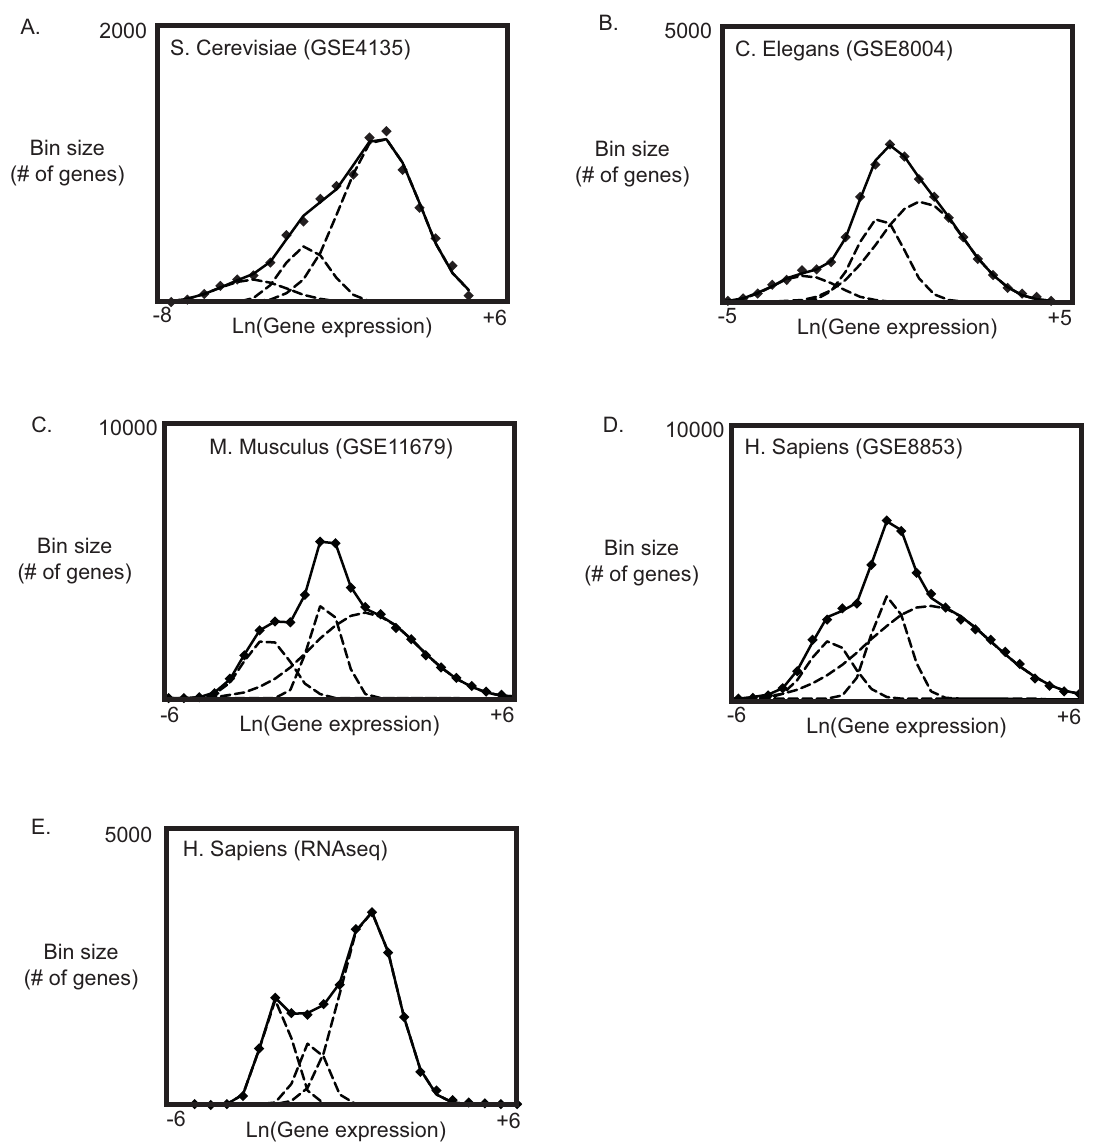
Figure 6. The presence of 3 log-normal gene expression distributions is a universal feature of gene expression in eukaryots. Data sets from S. cerviciae (GSE4135), C. elegans (GSE8004), and humans (GSE8853) were examined. The distribution of log-transformed gene expression levels was described by 3-log-normal distributions in all species examined (A–D). A human sample was examined with RNAseq. Approximately 23 thousand unique tags produced 17 million sequences. The distribution of log-transformed sequence tag counts was fit by 3-log normal distributions (E).